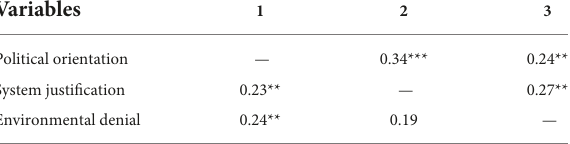
Correlationsforstudy1( n =148)areshownabovethediagonal.Correlationsforstudy2 (n=144)areshownbelowthediagonal.* p < 0.05.** p < 0.01.*** p <